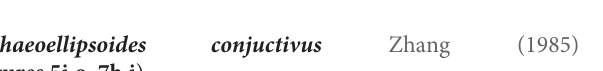
Archaeoellipsoides conjuctivus Zhang